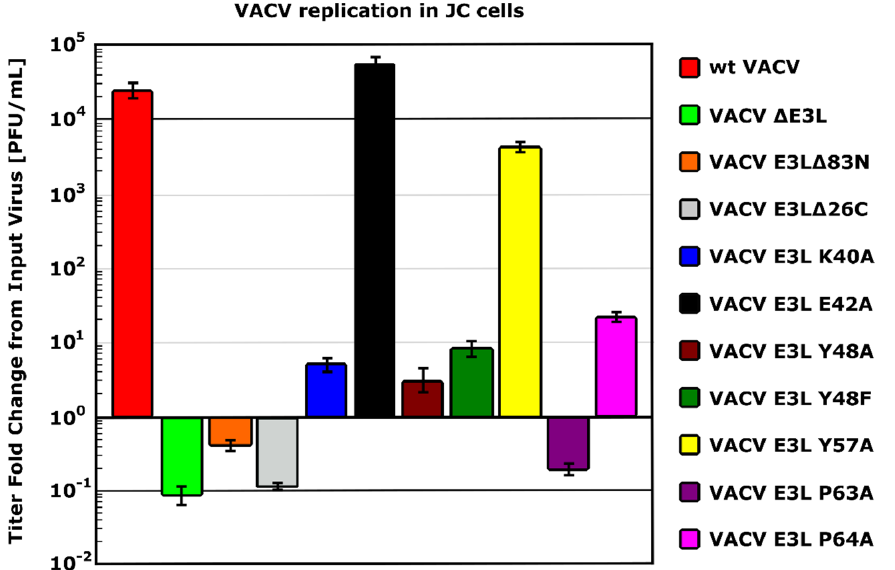
Figure 4. Replication of VACV expressing distinct mutants of E3 in JC cells. A multi-step growth curve was conducted for 72 h in JC cells infected at a multiplicity of infection (MOI) of 0.01. The output virus was normalized against the input virus and graphed. VACV expressing E3 mutants unable to bind to dsRNA ( E3L Δ 26C) and Z-DNA ( E3L Δ 83N, E3L Y48A, E3L P63A and partially impaired mutants E3L Y48F and E3L P64A) displayed limited ability to replicate in JC cells. Mutations in residues not associated with Z-DNA-binding (E42A and Y57A) did not appreciably affect replication in JC cells. This data demonstrates the importance of both the N- and C-terminal domains of E3 for virus replication in JC cells and it corresponds to what was seen in vivo (see the main text).